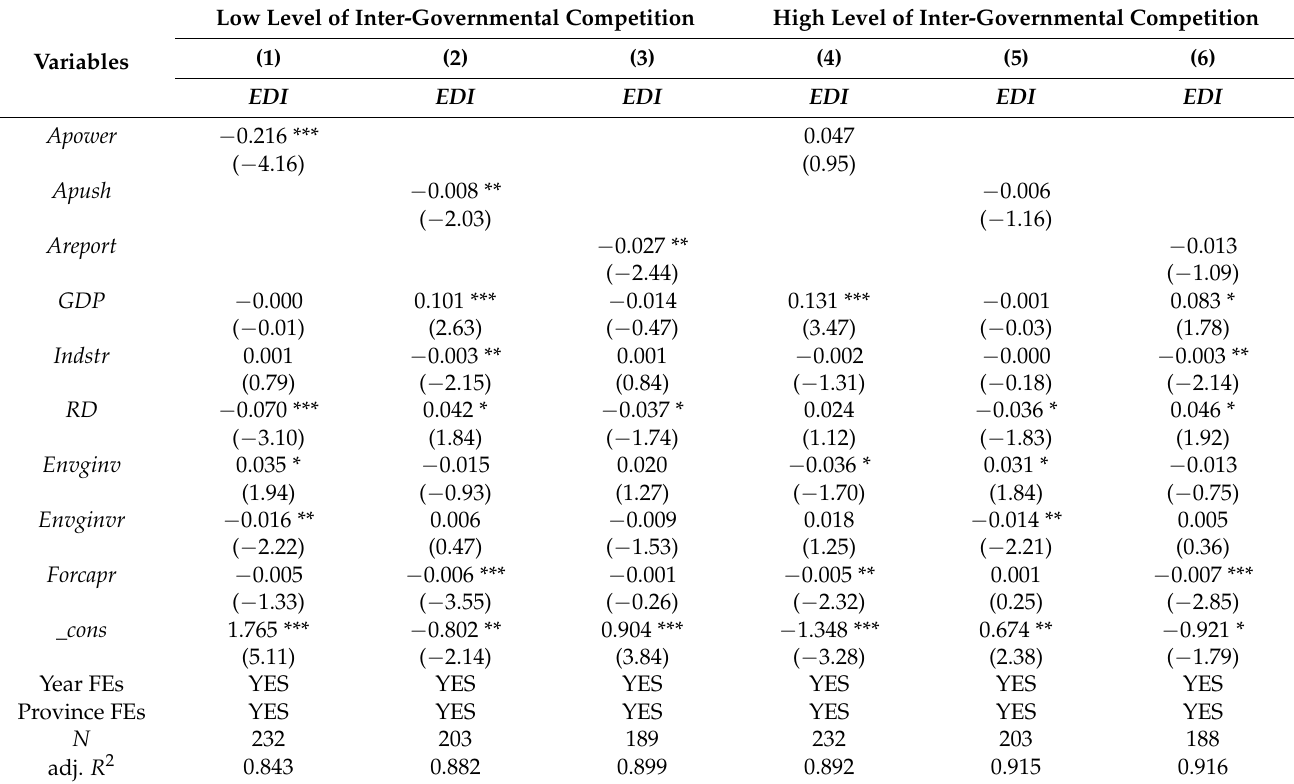
Table 6. Governmental environmental auditing, inter-governmental competition, and environmental